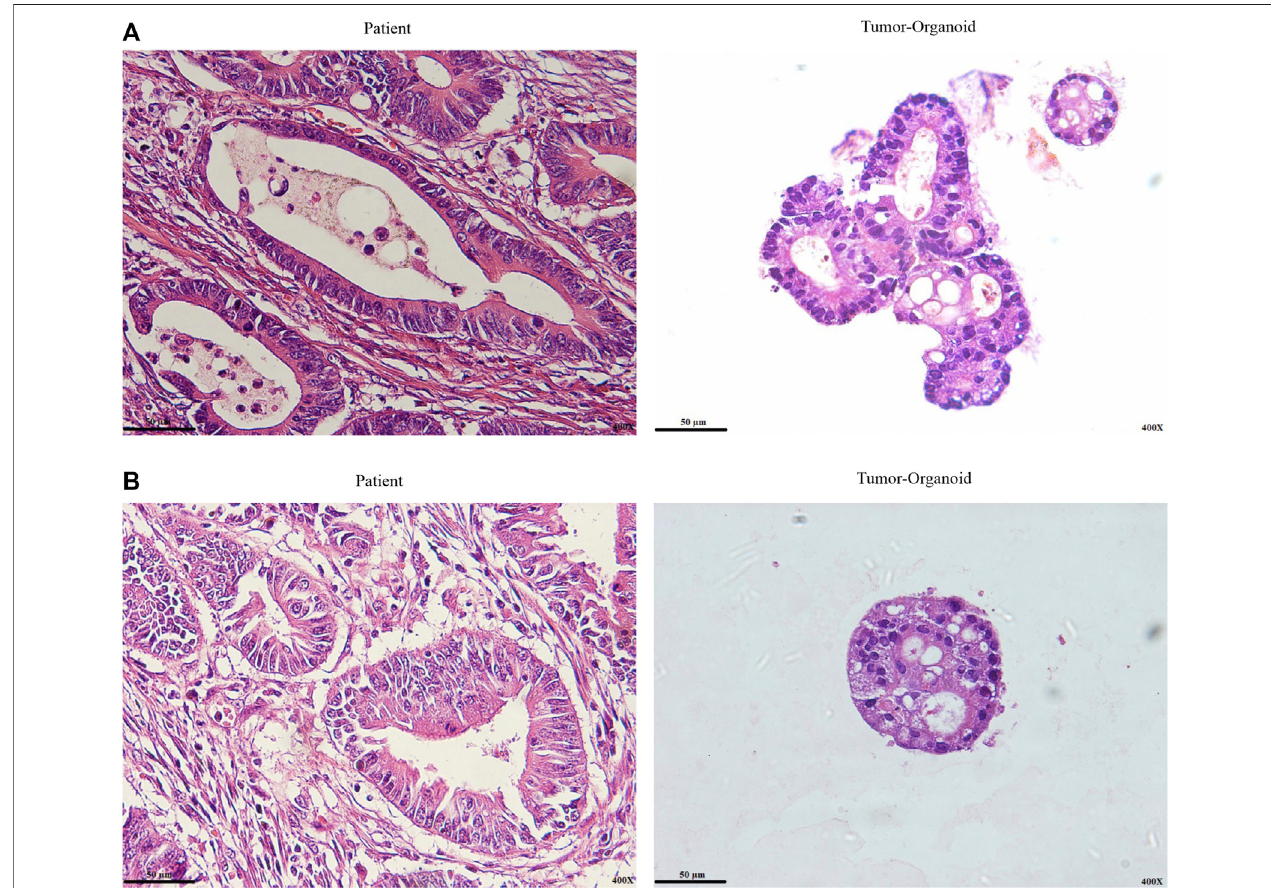
FIGURE 2 | Representative H&E staining of colon cancer organoid and patient tumor. (A) Well-differentiated adenocarcinoma. (B) Moderately differentiated adenocarcinoma.Histologicaldifferentiationpatternanalysisindicatedtumororganoidsretainpatienttumorhistopathologicalcharacteristics.Inbothparaf fi n-embedded sections from the original tumor and cultured organoids from the same patient, well-differentiated and moderately differentiated adenocarcinoma were seen. Scale bar: 50 μ m, ×400 magni fi cation.